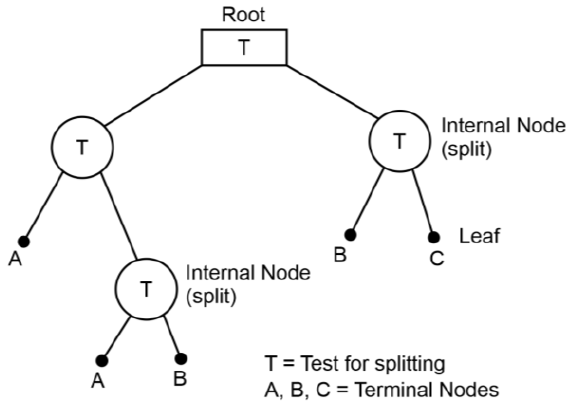
Figure 1. The structure of the CART.